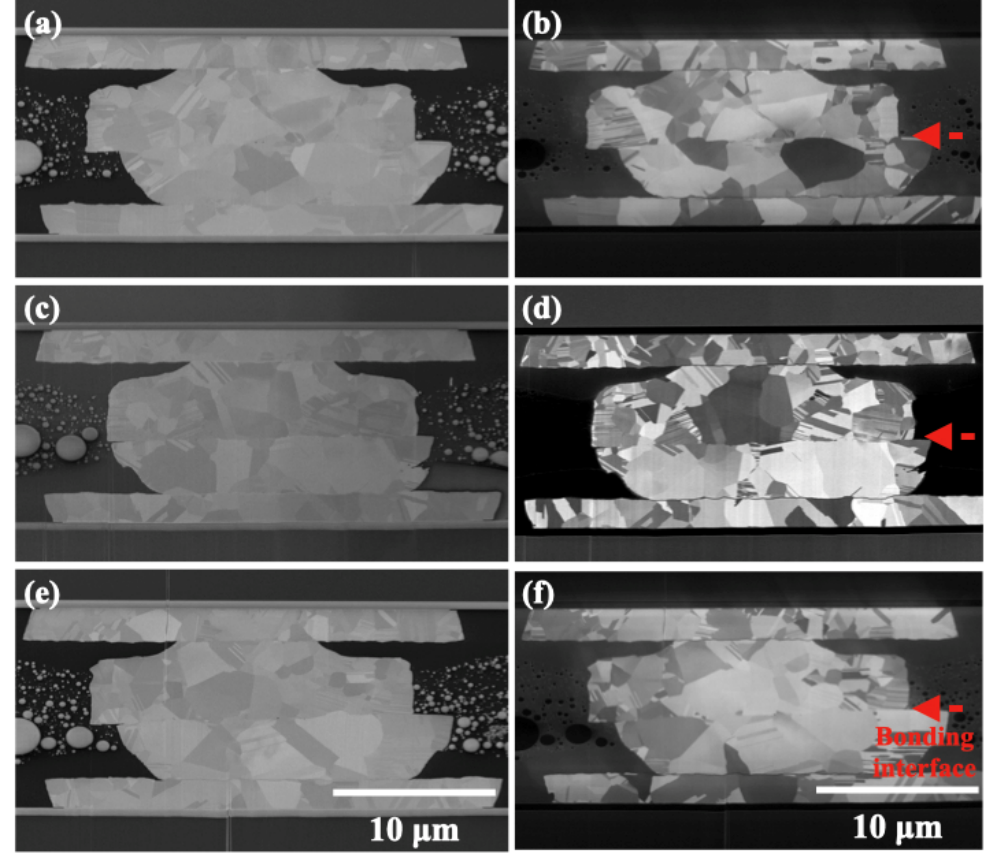
Figure 11. Cross-sectional FIB electron and ion images of the microbumps bonded under ( a , b ) 93 MPa/10 s, ( c , d ) 47 MPa/10 s, ( e , f ) 31 MPa/10 s. All samples were further heat-treated under 47 MPa/1 h/300 °C.